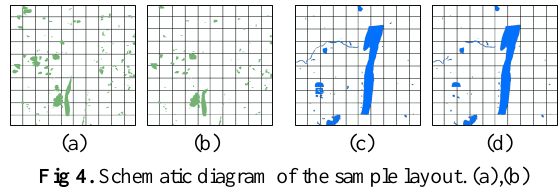
Fig 4. Schematic diagram of the sample layout. (a),(b) respectively represent the sampling layer and sampling result of vegetation;(c),(d) respectively represent the sampling layer and sampling result of water